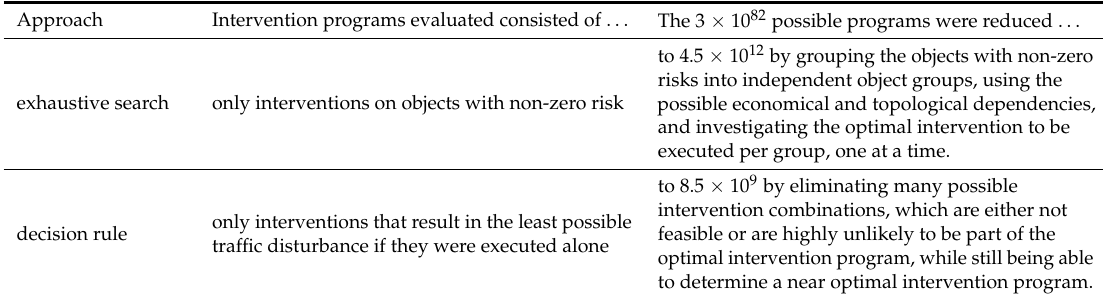
Table 10. Approaches used for